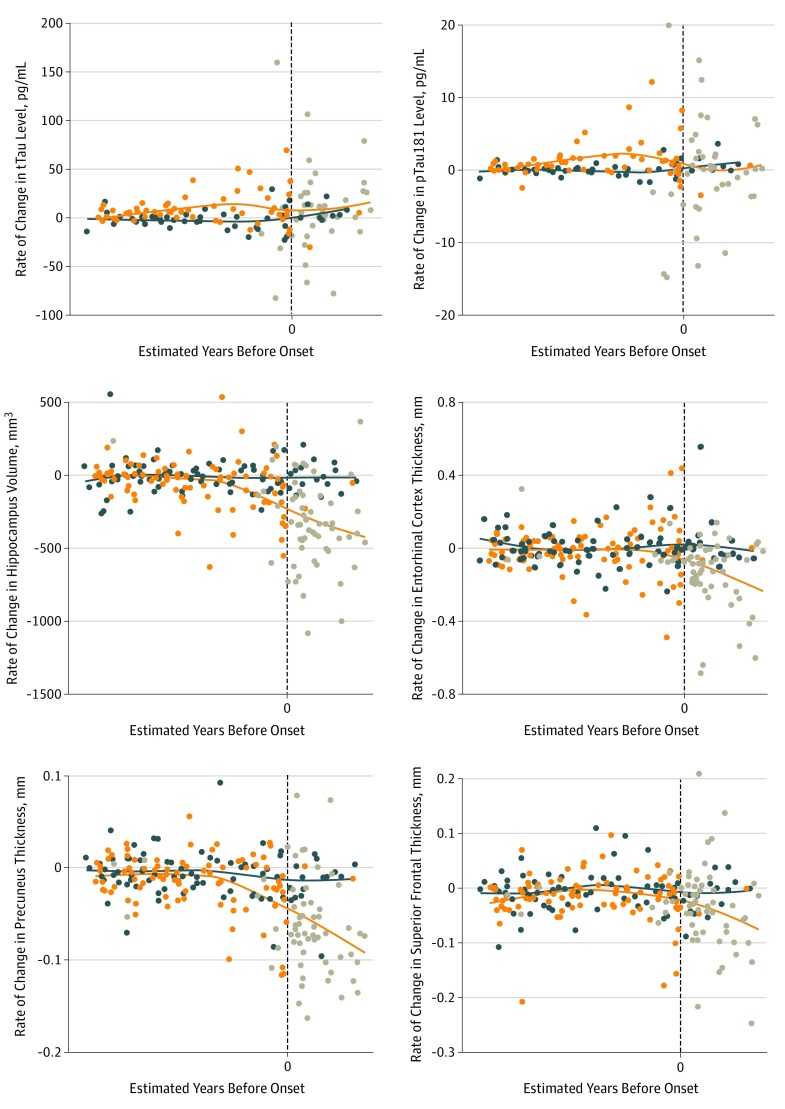
Individual Annual Rate of Change of Cerebrospinal Fluid Levels of Total Tau (tTau) and Phosphorylated Tau 181 (pTau181) and Brain Structures by Magnetic Resonance Imaging as a Function of Baseline Estimated Years Before Onset in Mutation Carriers and NoncarriersValues for noncarriers (blue dots), mutation carriers without symptoms (orange dots), and mutation carriers with symptoms (gray dots) are shown. Blue and orange lines are locally estimated scatterplot smoothing curves for mutation carriers and noncarriers, respectively. To maintain participant and investigator blinding to mutation status when reporting individual data points, specific estimated years before onset are not shown (vertical dashed line indicates year 0). Individual annual rate of change over the longitudinal follow-up was estimated for each participant separately using linear regressions.